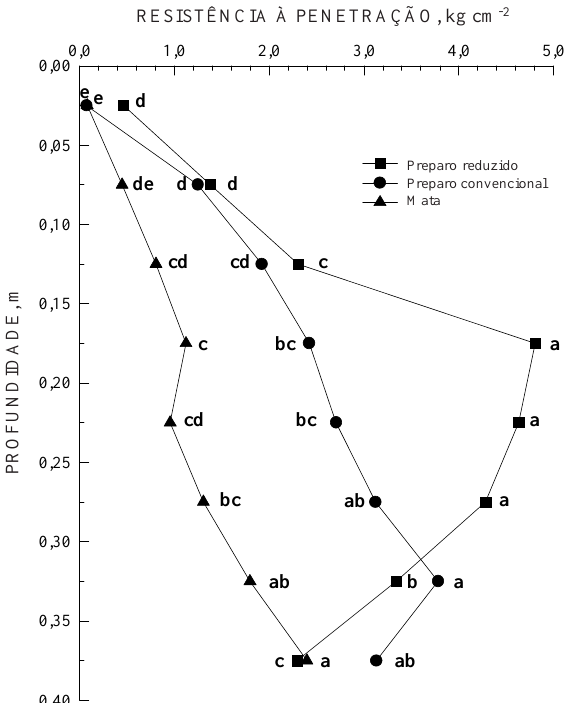
Figura 6. Resistência do solo à penetração no sis- tema de preparo reduzido, preparo convencio- nal e mata, na profundidade de 0–0,40 m (ja- neiro de 1999). Letras diferentes indicam dife- rença estatística entre as profundidades em cada sistema de cultura (Duncan, 5